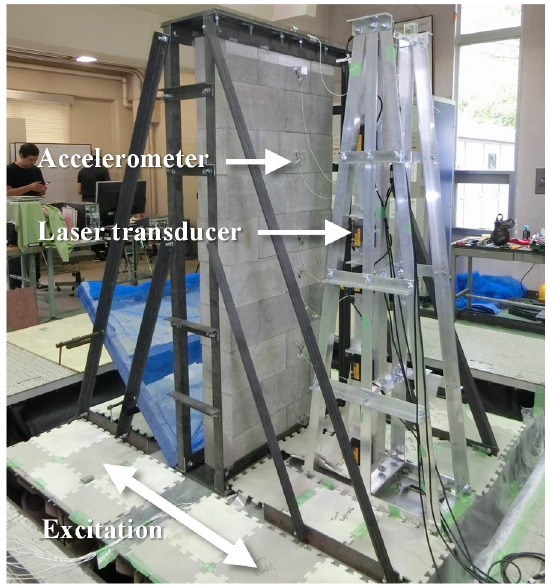
Figure 9. Overall view of test setup.